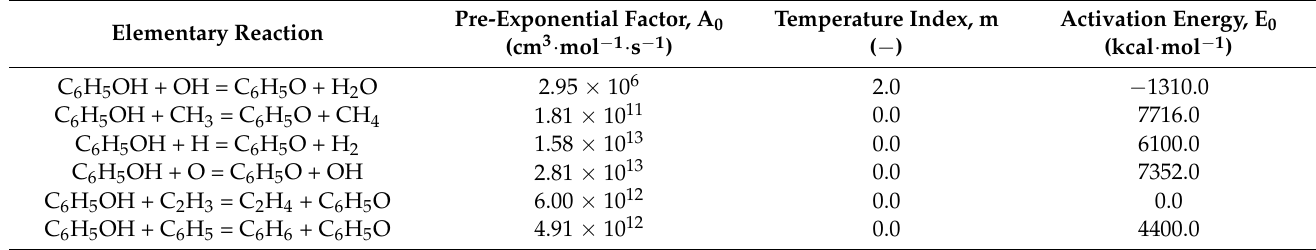
Table A2. Elementary reactions and chemical reaction kinetic parameters related to the C 6 H 5 CH 3 [25].